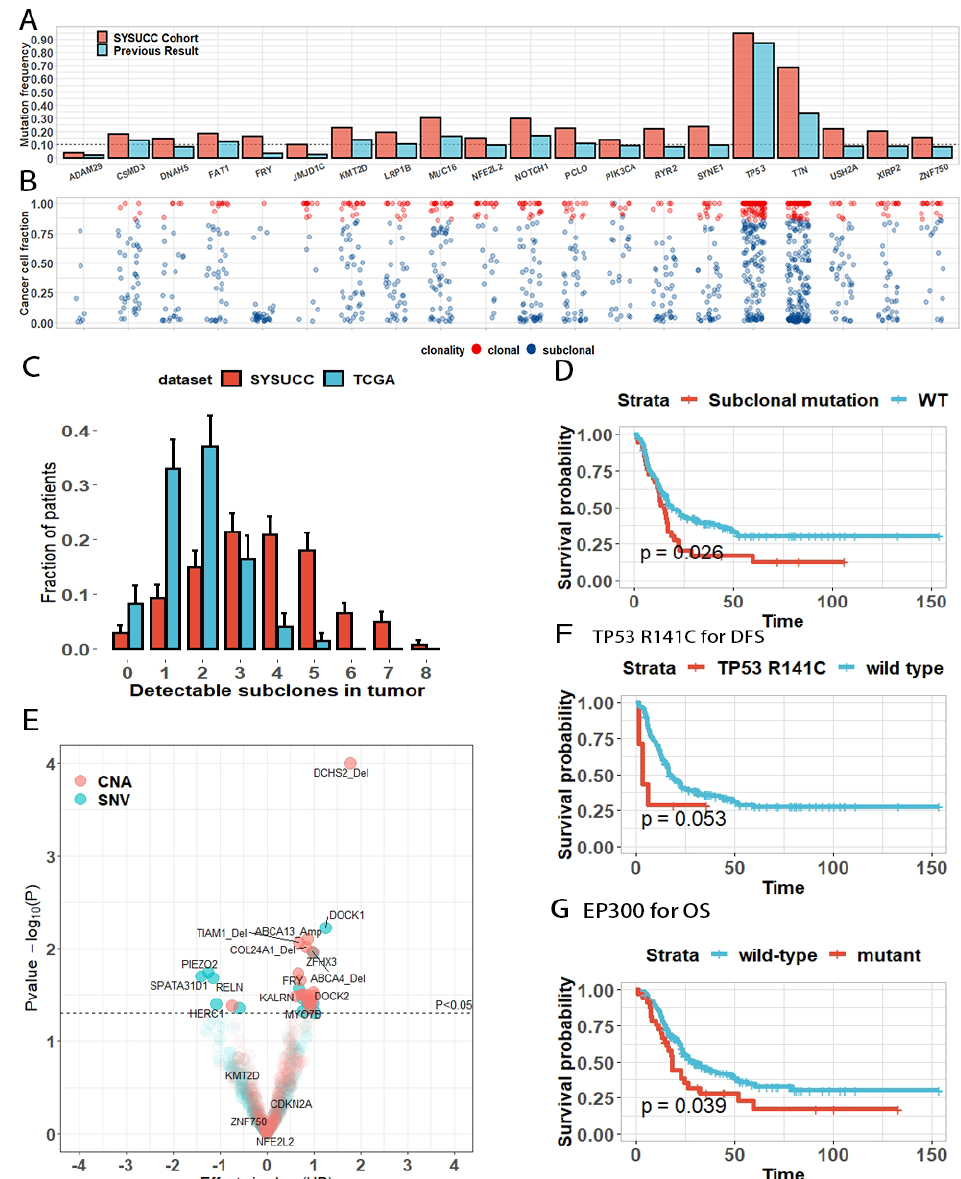
Figure 1. Heterogeneity and clinical impact of alterations in ESCC. ( A ) Bar plot for comparison of mutation frequencies of the most frequently mutated genes observed in previous results and our cohort. ( B ) Scatter plot of cancer cell fraction of mutations in these frequently mutated genes. Clonal mutations are shown in red and subclonal mutations in blue. ( C ) Predicted number of subclones in ESCC. For comparison, the predicted number of subclones from patients in TCGA-ESCC cohort is also shown. Error bar represents the standard deviation. ( D ) Disease-free survival difference between patients with subclonal FRY mutations and wildtype FRY. ( E ) Volcano plot displays the re- lationship between genetic alterations and DFS. The X and Y axes indicate 𝑙𝑜𝑔 (cid:2870)(cid:3009)(cid:3019) and −𝑙𝑜𝑔 (cid:2869)(cid:2868)(cid:3017) , re- spectively. “Amp” and “Del” represent the amplification and deletion of the gene, respectively. ( F ) TP53 R141C hotspot mutation was associated with inferior DFS. ( G ) EP300 mutation was associated with grave OS.